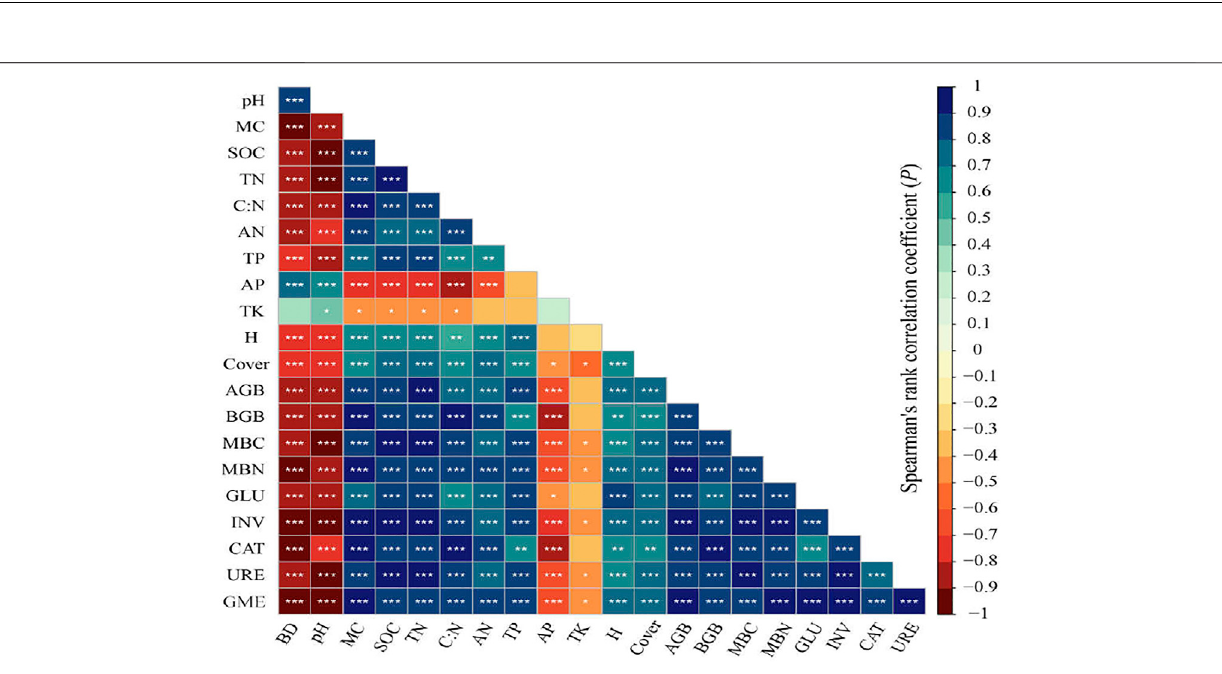
FIGURE 5 | Correlation matrix of soil microbial biomass, enzyme activities, soil physico-chemical properties, and plant properties. The correlation coef fi cient ( r -value) is represented by different colors. *** p < 0.001; ** p < 0.01; * p < 0.05. BD, bulk density; MC, moisture content; SOC, soil organic carbon; TN, total nitrogen; AN, available nitrogen; TP, total phosphorus; AP, available phosphorus; TK, total potassium; H, plant height, Cover, plant coverage; AGB, aboveground biomass; BGB, belowgroundbiomass;MBC,microbialbiomasscarbon;MBN,microbialbiomassnitrogen;GLU, β -glucosidase;INV,invertase;CAT,catalase;URE,urease;GME, geometric mean of enzyme